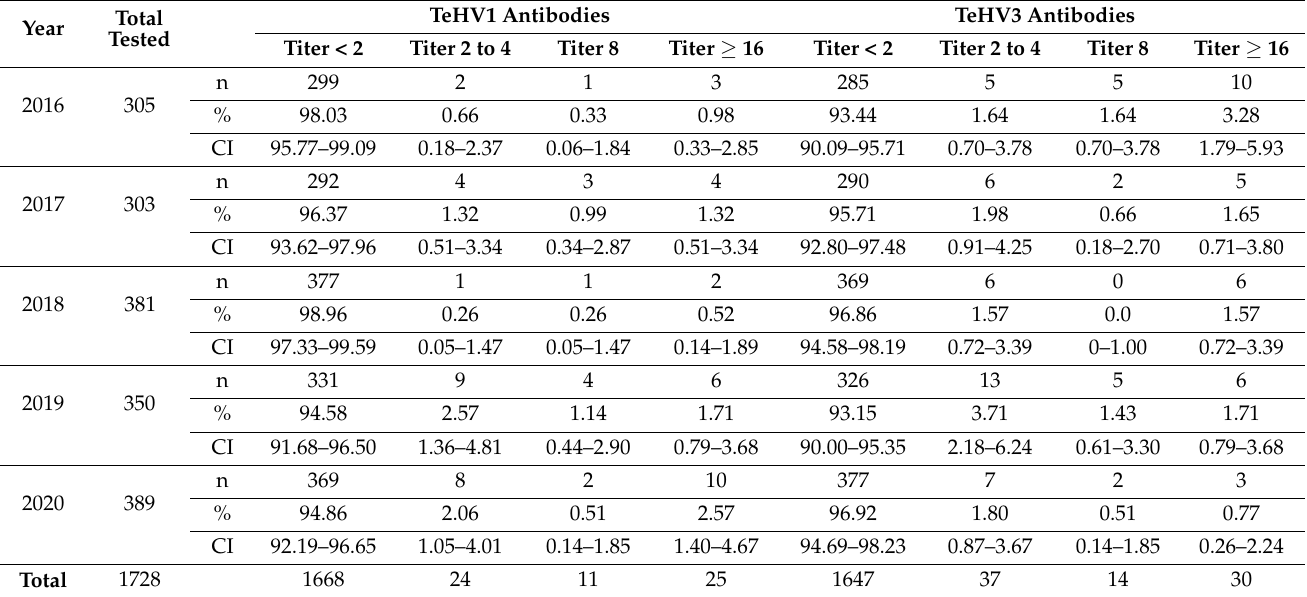
Table 2. Detection rates of antibodies against testudinid herpesvirus 1 (TeHV1) and testudinid herpesvirus 3 (TeHV3) depending on year of sampling. Results shown as: number (n), percent (%), 95% confidence interval (CI).